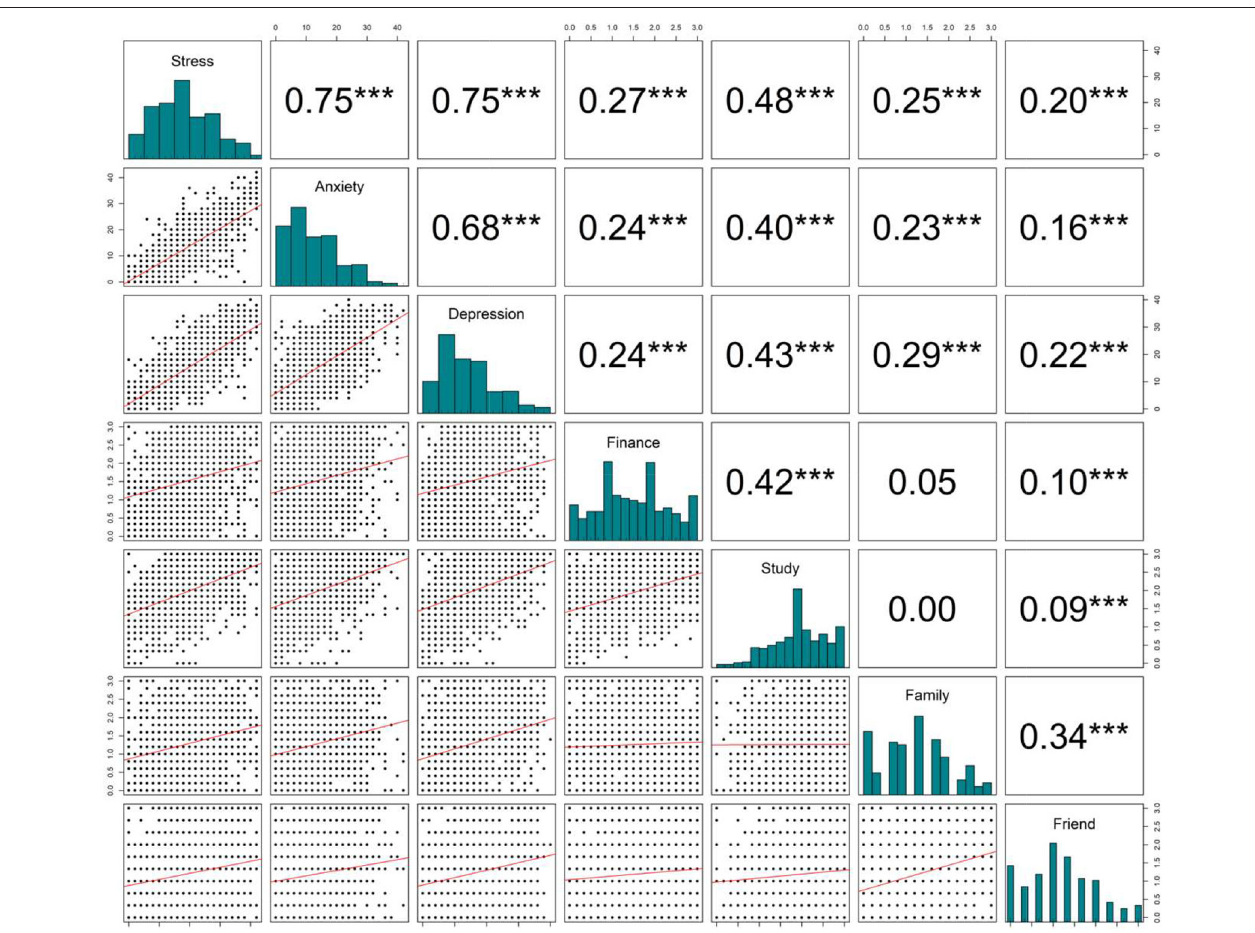
FIGURE 2 | Correlation matrix of DASS21 score (depression, anxiety, and stress scores) and four components of FSFF scale. *** p <